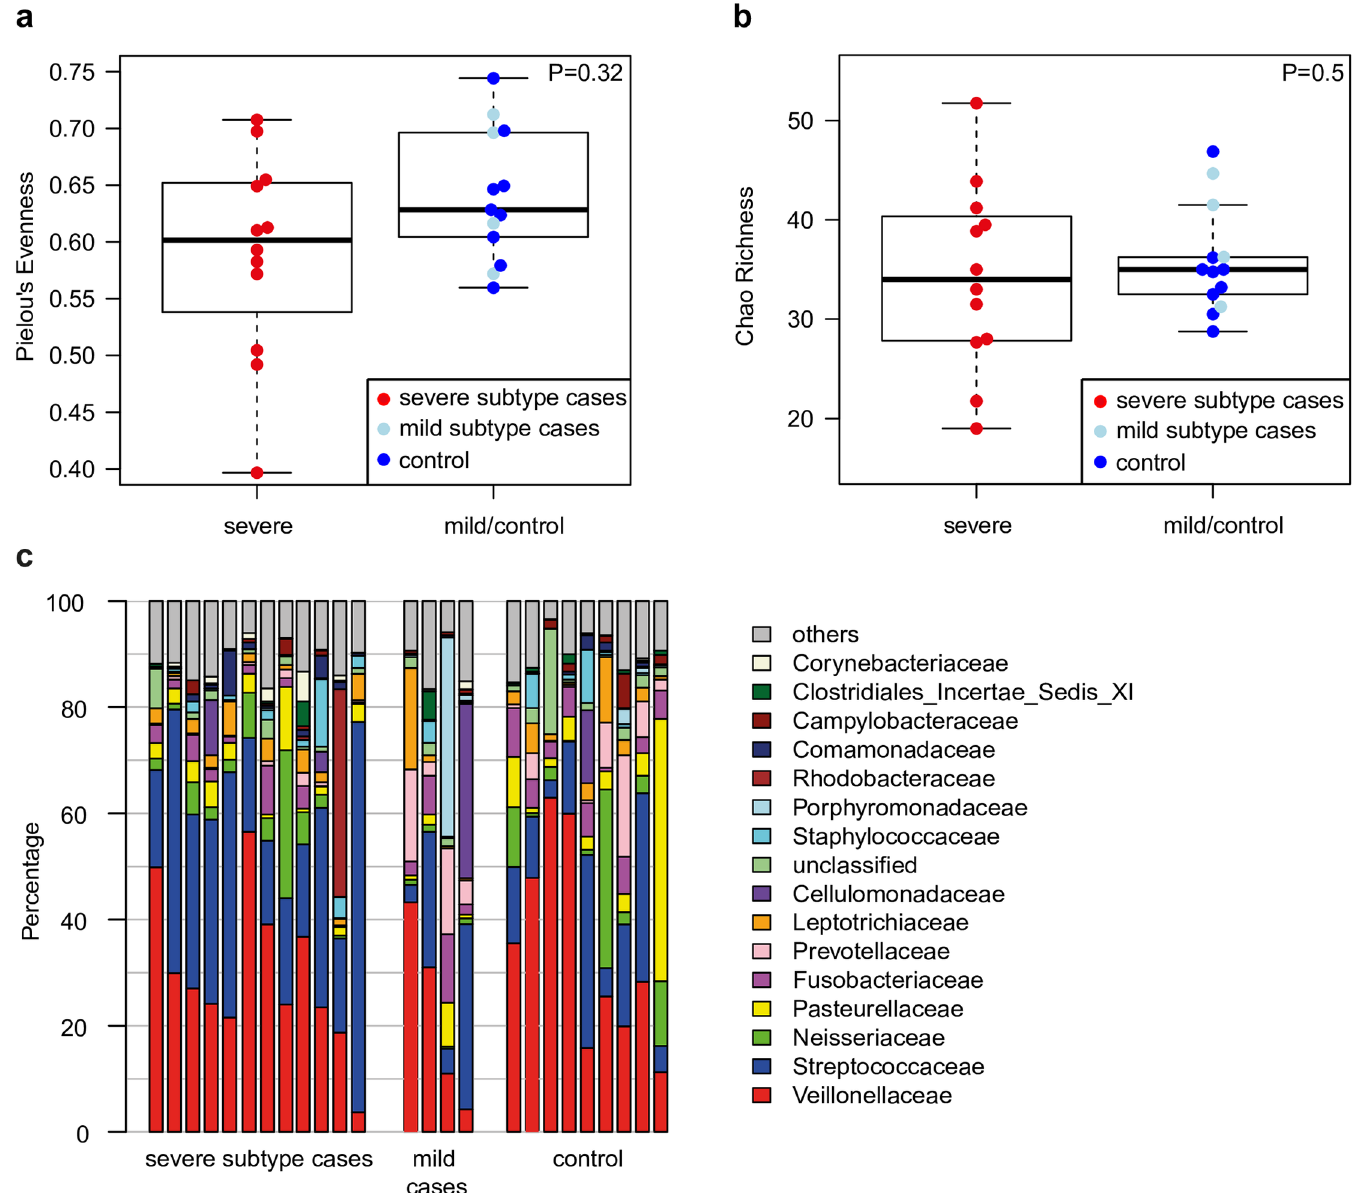
Fig 2. Diversity of microbial communities derived from lungs of severesubtype cases and mild subtype and control individuals. ( a ) Pielou’s evennessand ( b ) Chao richness of microbialcommunities on genuslevel for severe vs mild/control samples. P-values were computedbased on two-sided Wilcoxon-Mann-Whitney tests after correction for confounding effects from samplesprocessedduringwinter or summer, respectively. ( c ) Phylogenetic community compositionbasedon 16S rRNA gene fragment sequencesin bronchialbrushingsamples. Bars represent the relativeabundanceof the most abundantfamilies ( > 5%in one sample). The remainingfamilies are subsumedas others.